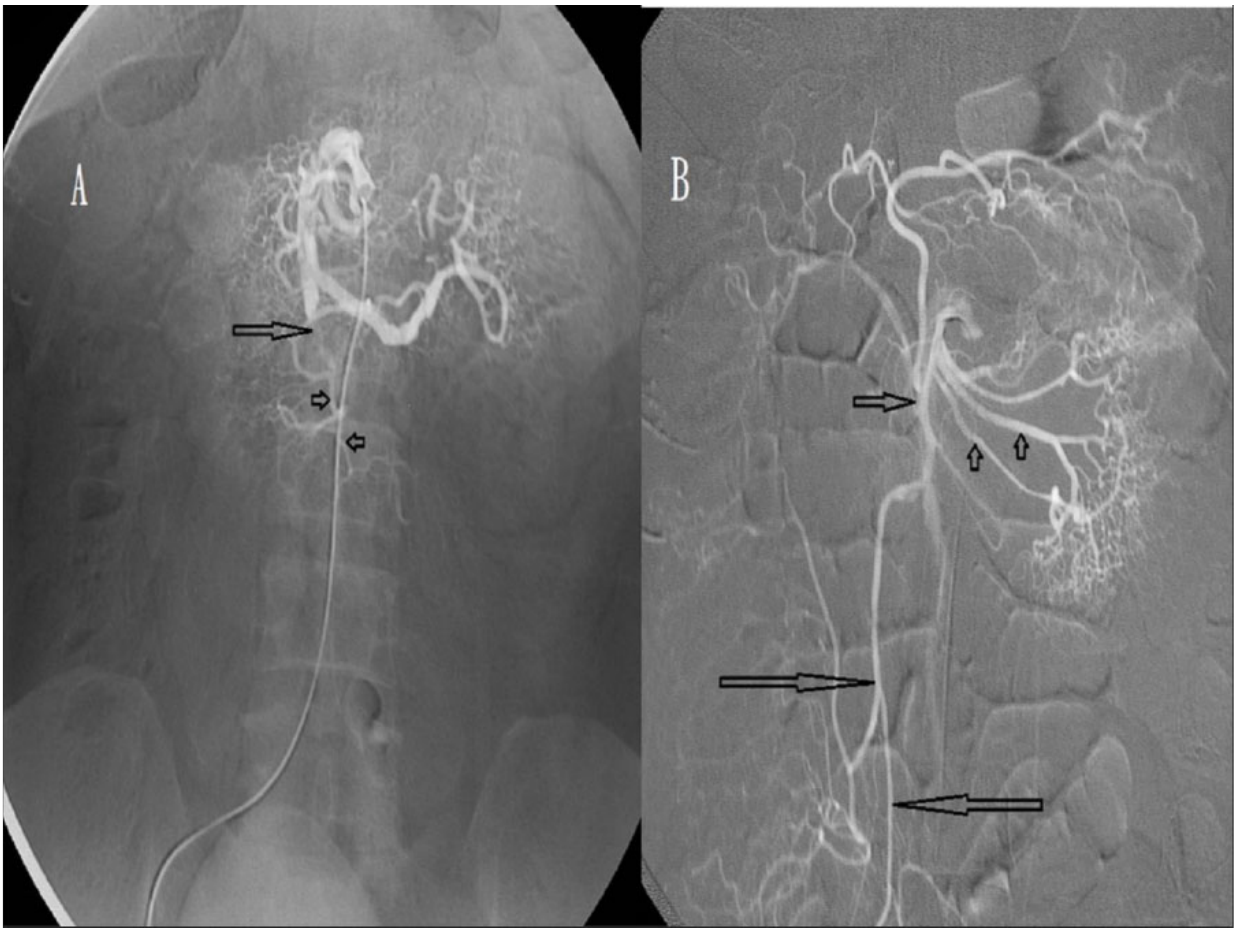
Figure 4. ( A ) Angiography of a 50-year-old man, showing incomplete occlusion (arrow) of the superior mesenteric artery (SMA). Distal main trunk of the SMA is visible (arrowheads). ( B ) Angiography obtained after one day of urokinase infusion, showing partial recanalisation of the previous occlusion (short arrow). Most of the jejunal arteries (arrowheads) and colic arteries (long arrow) are visible.